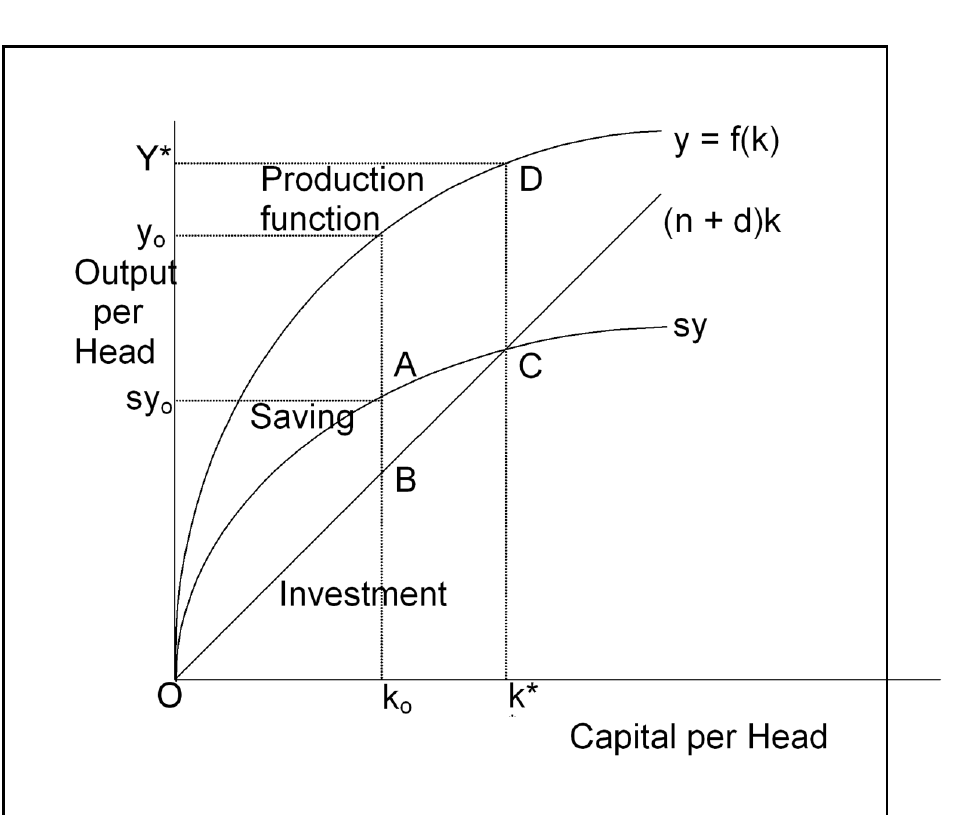
Figure 4. Increase in